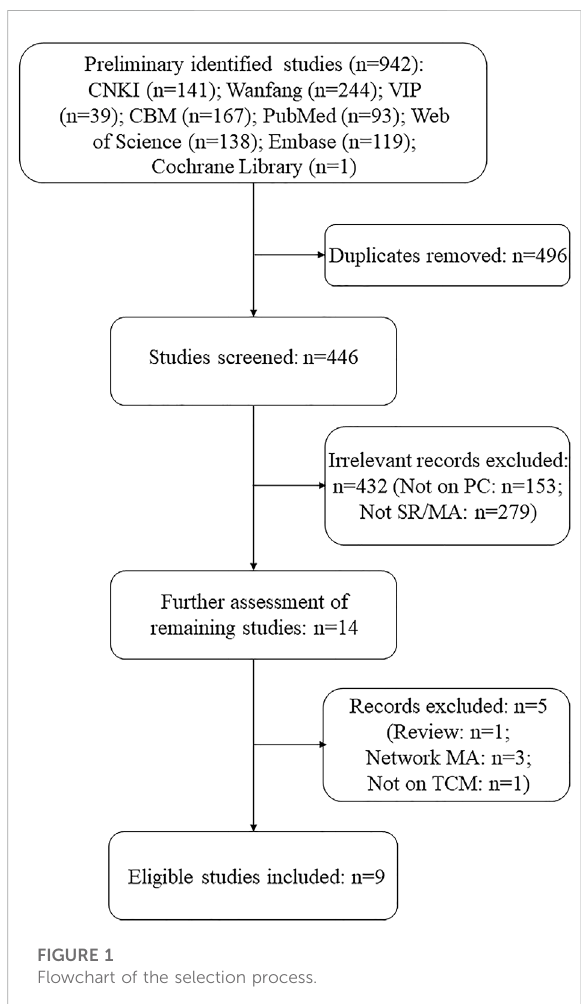
Flowchart of the selection